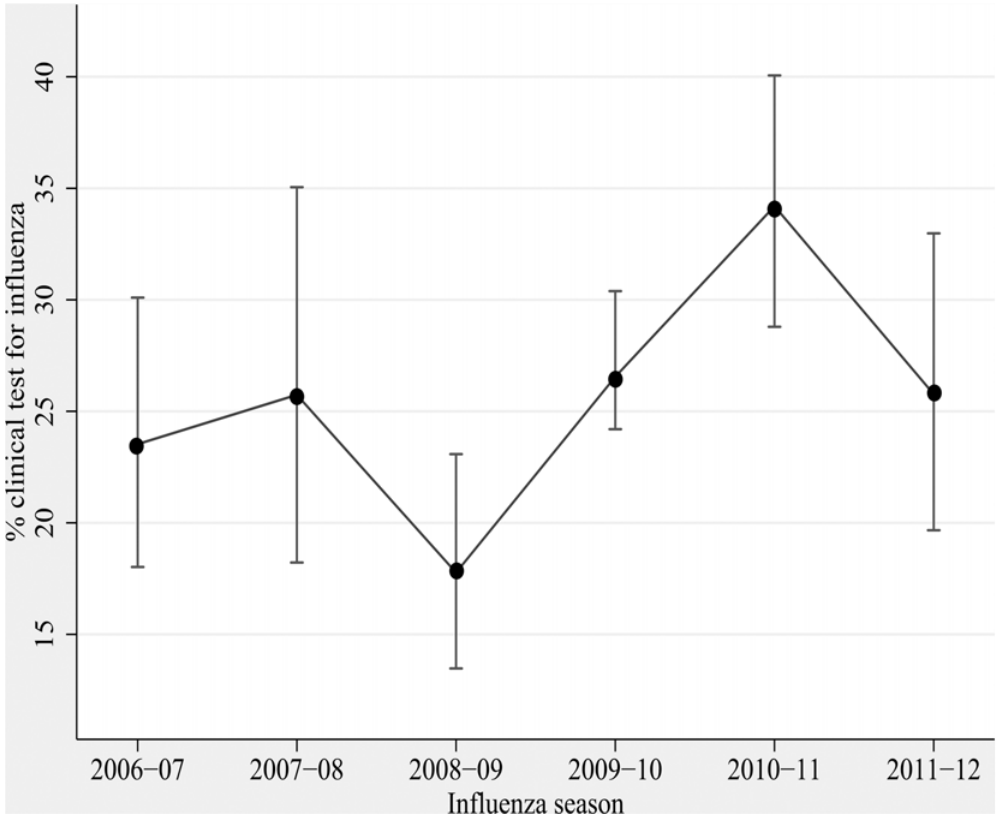
Fig 1. Clinical diagnostic testing among adults (cid:1) 50 years of age hospitalized with acute respiratory illness, by season, 2006 – 2012.